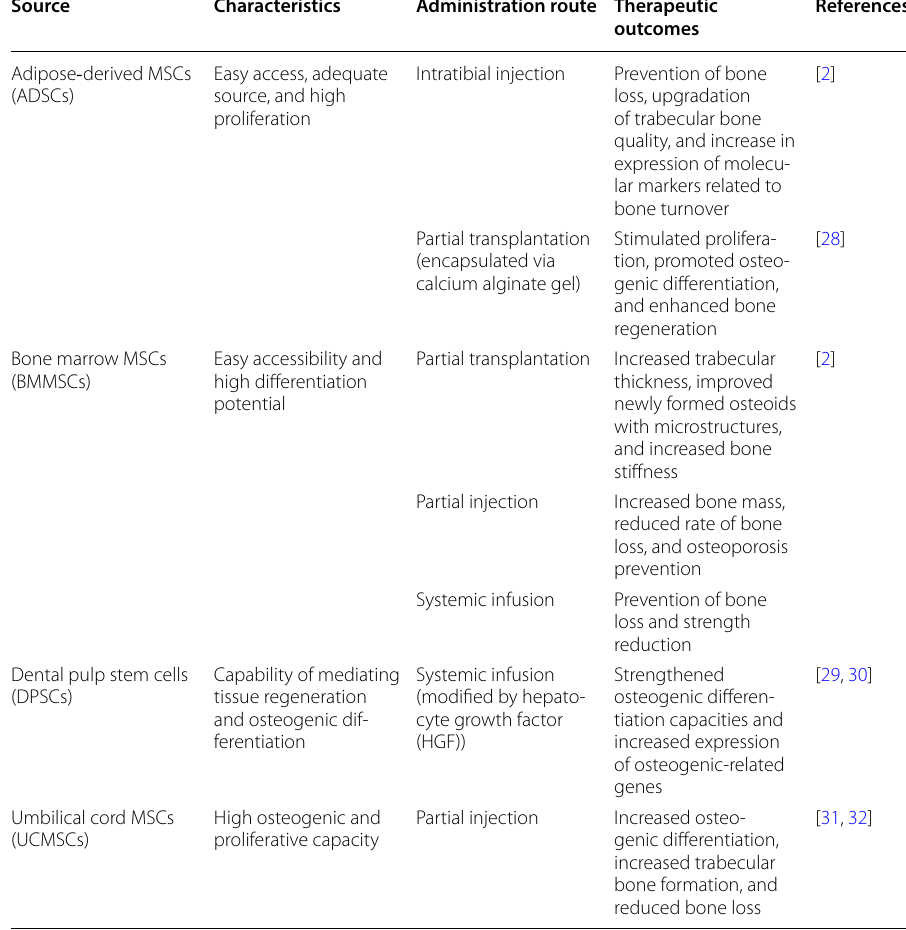
Table 1 Application of MSCs from various sources and their therapeutic outcomes